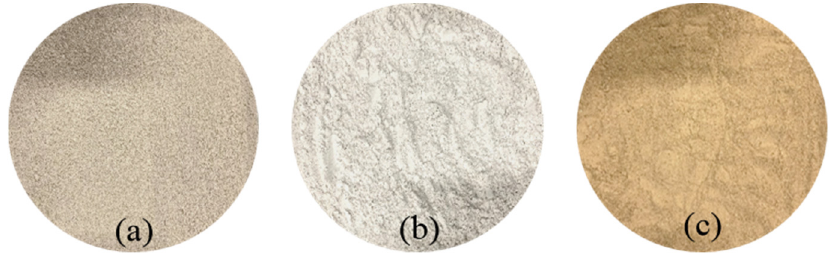
Table 1. Basic physical properties of loessial silt.